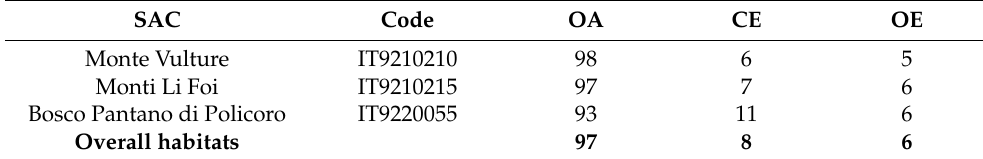
Table 2. Accuracy metrics for the investigated SACs and for the overall habitats of the three sites.